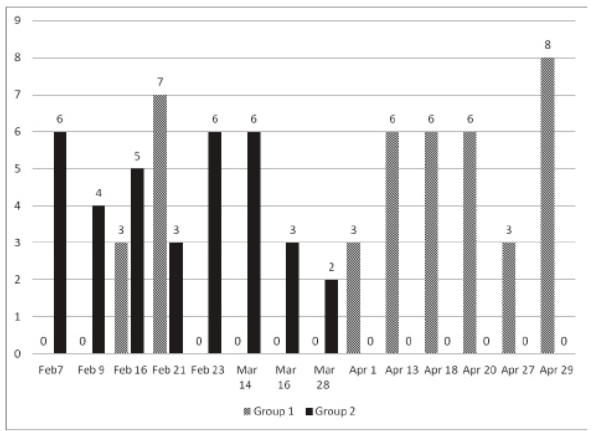
Figure 6. Numbers of different SPT roles adopted by each group across time